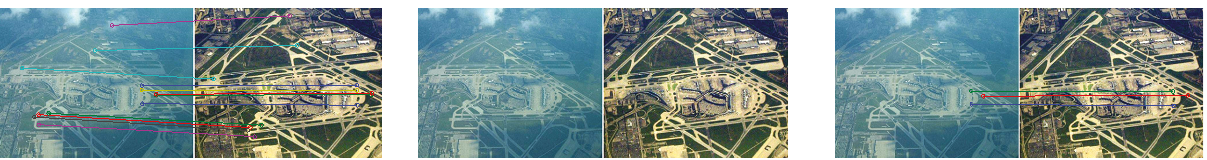
Figure 19: O ’ Hare International Airport registration result with SURF, PCA-SURF, and CSA-SURF.